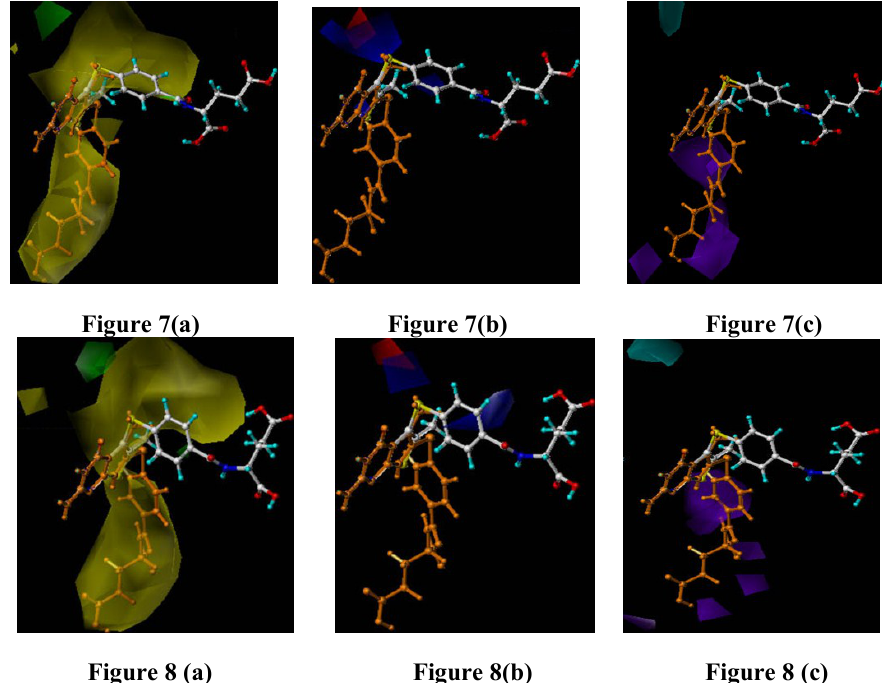
(a) Steric contour maps for LB and RB CoMSIA. (b) Electrostatic contour maps for LB and RB CoMSIA. (c) Hydrogen bond donor contour maps for LB and RB